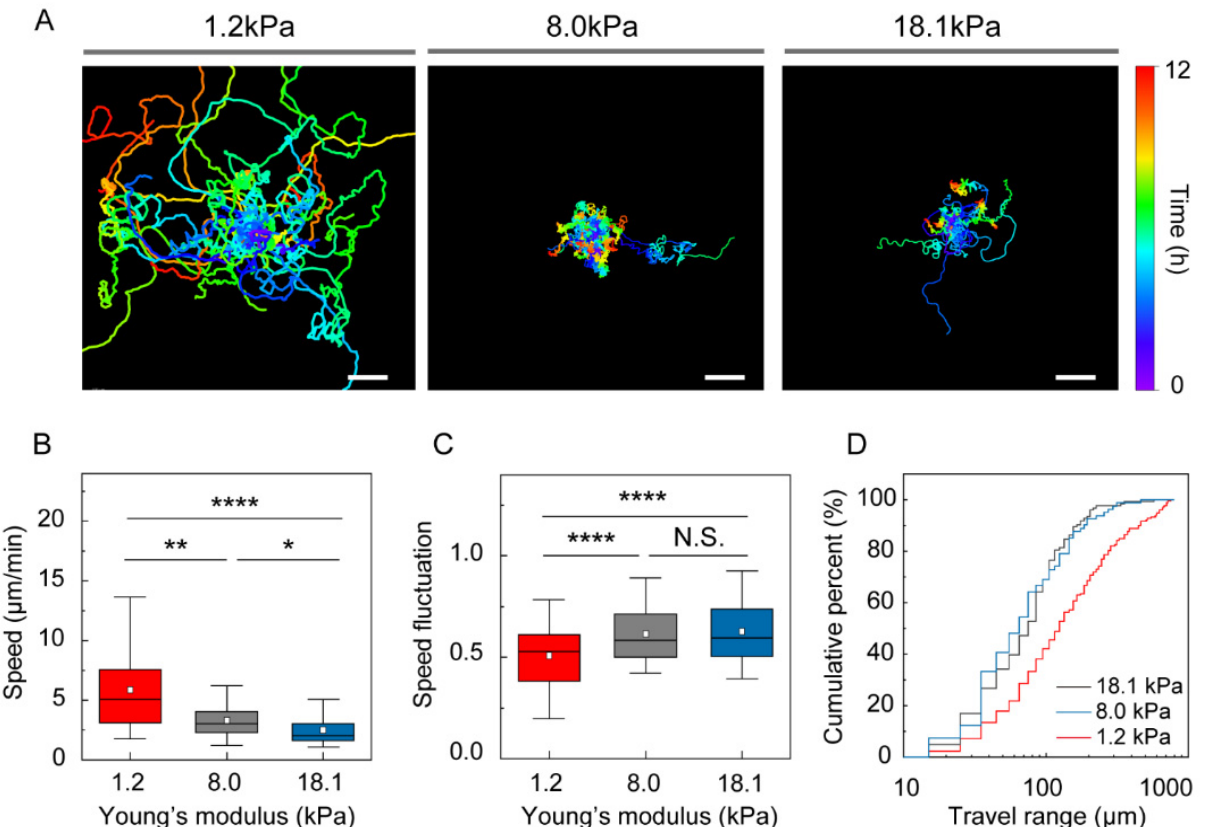
Figure 2. 2D random motility of immature DCs under different mechanical loads. ( A ) Representative DC trajectories during the 12 h, with time-dependent color coding. The starting point of each trajectory was translated to the origin of the plot. One representative experiment of three is shown. Scale bar = 100 µm. ( B ) Mean track speed and ( C ) speed fluctuation of DCs as a function of stiffness of the surrounding gel. In the box plots, bars include 95% of the data, boxes contain 75% of the data, center bars are medians, and square points are means. Kruskal–Wallis/Dunn’s multiple comparisons test used for comparisons of different sample populations; N.S.: p > 0.05; *: p < 0.05; **: p < 0.01; ****: p < 0.0001. ( D ) Cumulative percent of the DC travel range indicating how far DCs move during the 12 h observation period. Data were pooled from three independent biological replicates; 1.2 kPa, n = 195; 8.0 kPa, n = 123; 18.1 kPa, n = 81.